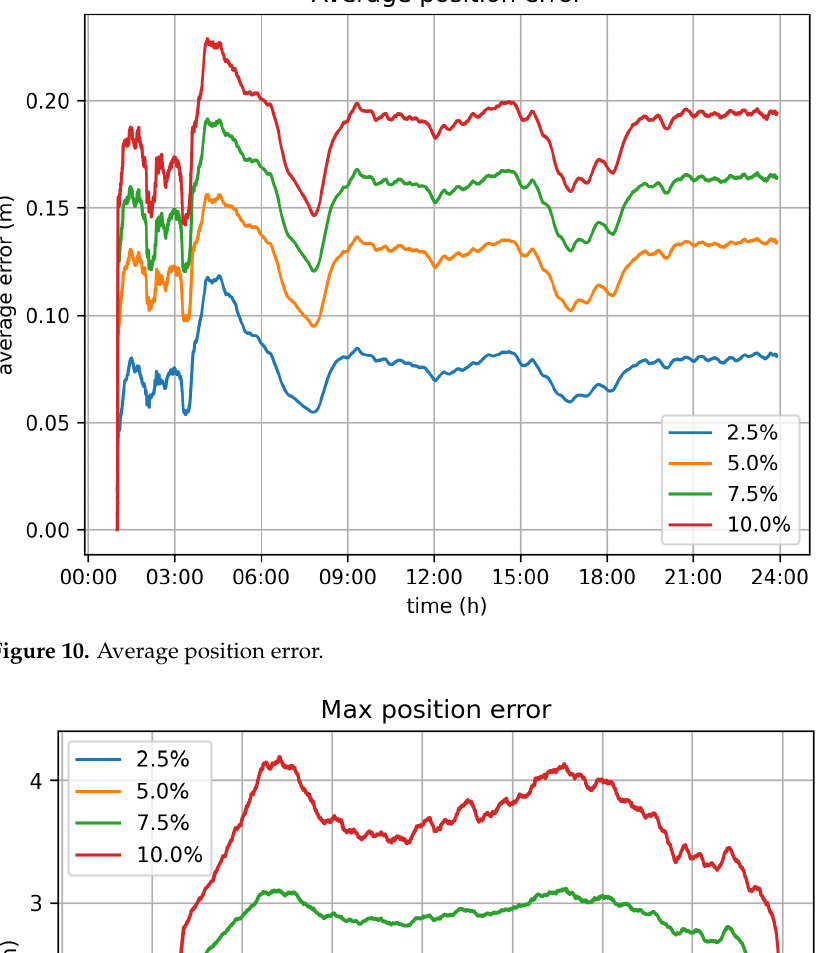
Figure 10. Average position error.